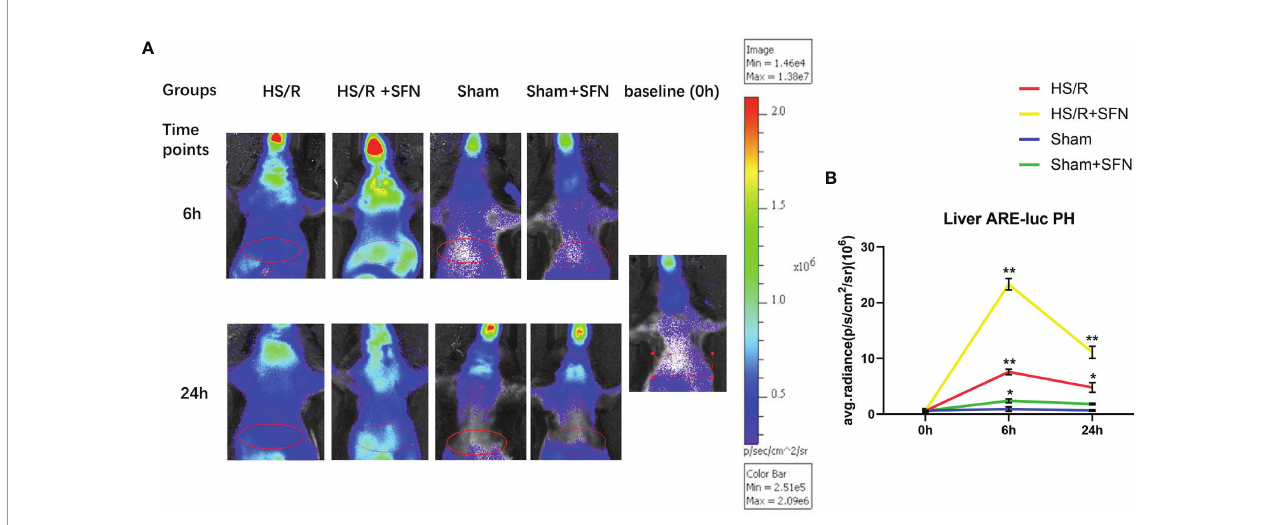
FIGURE 1 | Bioluminescence emission of the liver region of ARE-luc mice (n=6 in each group). The ARE-luc transgenic mice underwent an HS/R or sham operative procedure. The luciferase activity in vivo was measured via BLI after the intraperitoneal injection of luciferin preoperatively (0 h) and post operatively (6 h and 24 h). The red ellipses mark the selected ROIs used to evaluate signal intensity. (A) The representative animals for each group and time point. High signal intensities were also observed around the neck, chest, and the nasal and oral cavity. (B) The in vivo hepatic luciferase activity was recorded as the average radiance in photons per second per cm 2 per steradian (p/s/cm 2 /sr), which represents the mean values for six animals and the standard deviation (*p < 0.05, **p < 0.01; One-way ANOVA followed by Tukey ’ s post hoc